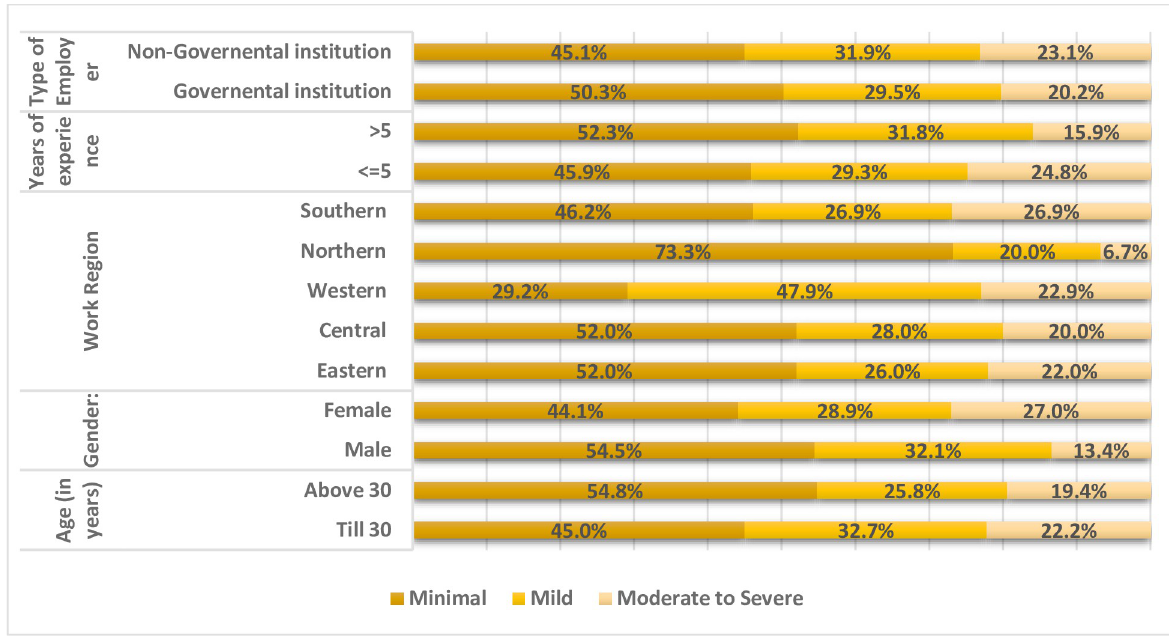
Fig 1. Anxiety level endured by physical